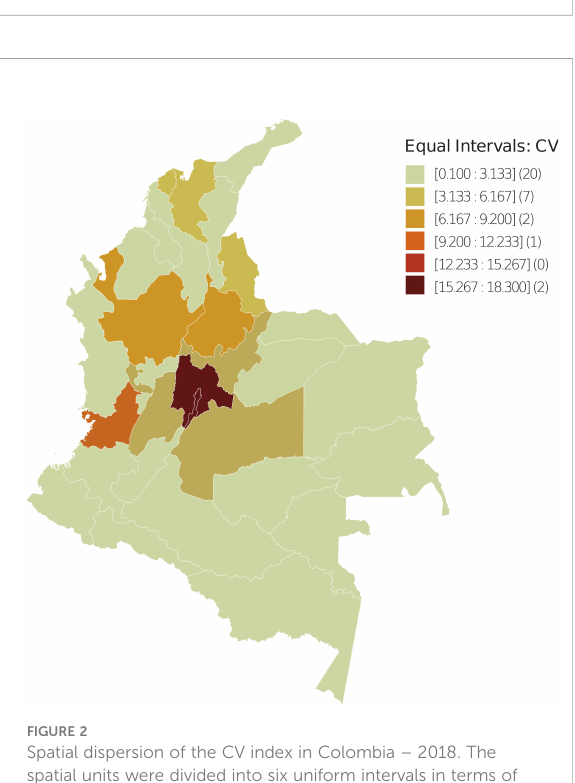
FIGURE 2 Spatial dispersion of the CV index in Colombia – 2018. The spatial units were divided into six uniform intervals in terms of CV values. Between parentheses is the number of spatial units with CV value in the corresponding